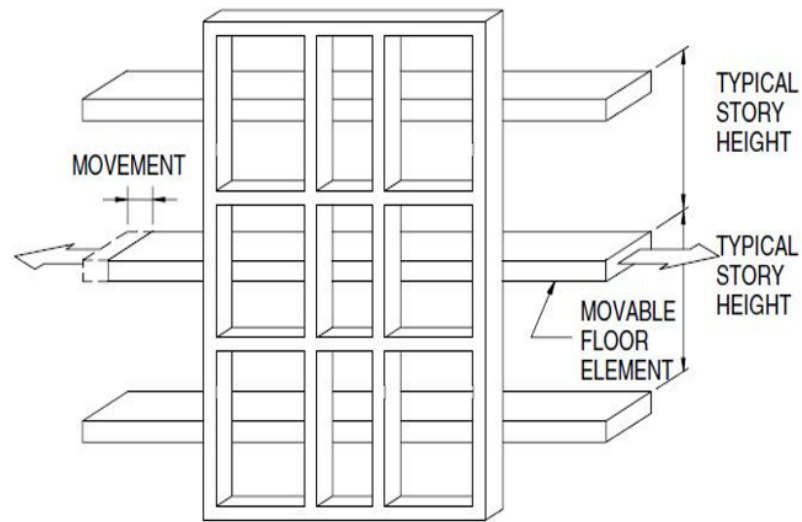
Figure 1. Test methods in the AAMA 501.4 standard.